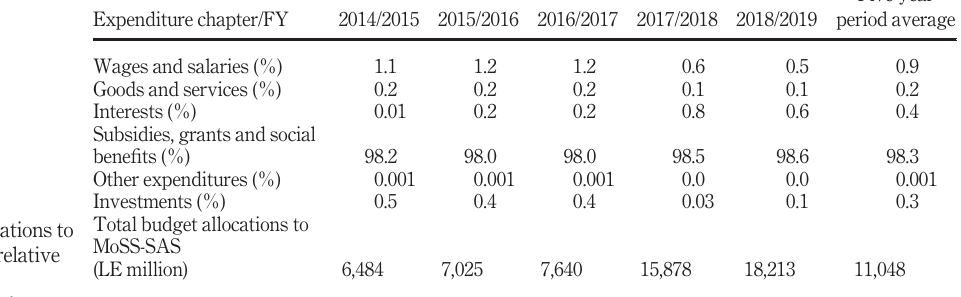
Table 3. Budget allocations to MoSS-SAS: relative shares by expenditure